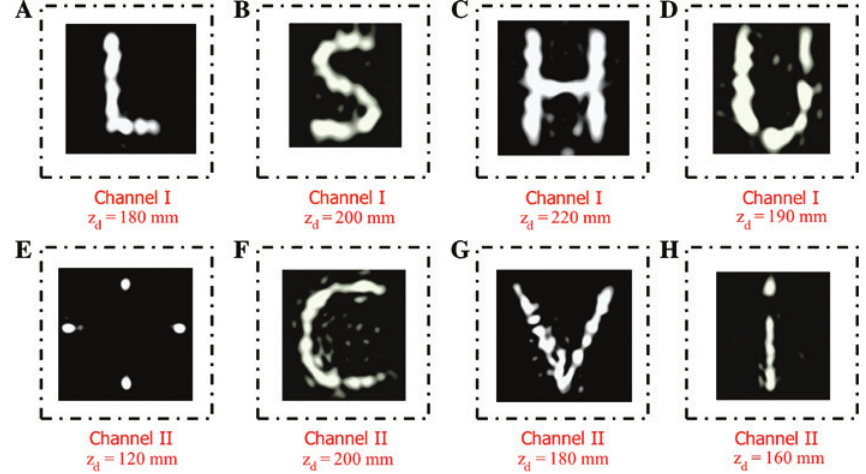
Figure 6: The simulated results of different sets of holographic images projected at the low-frequency (top row) and high-frequency (bottom row)